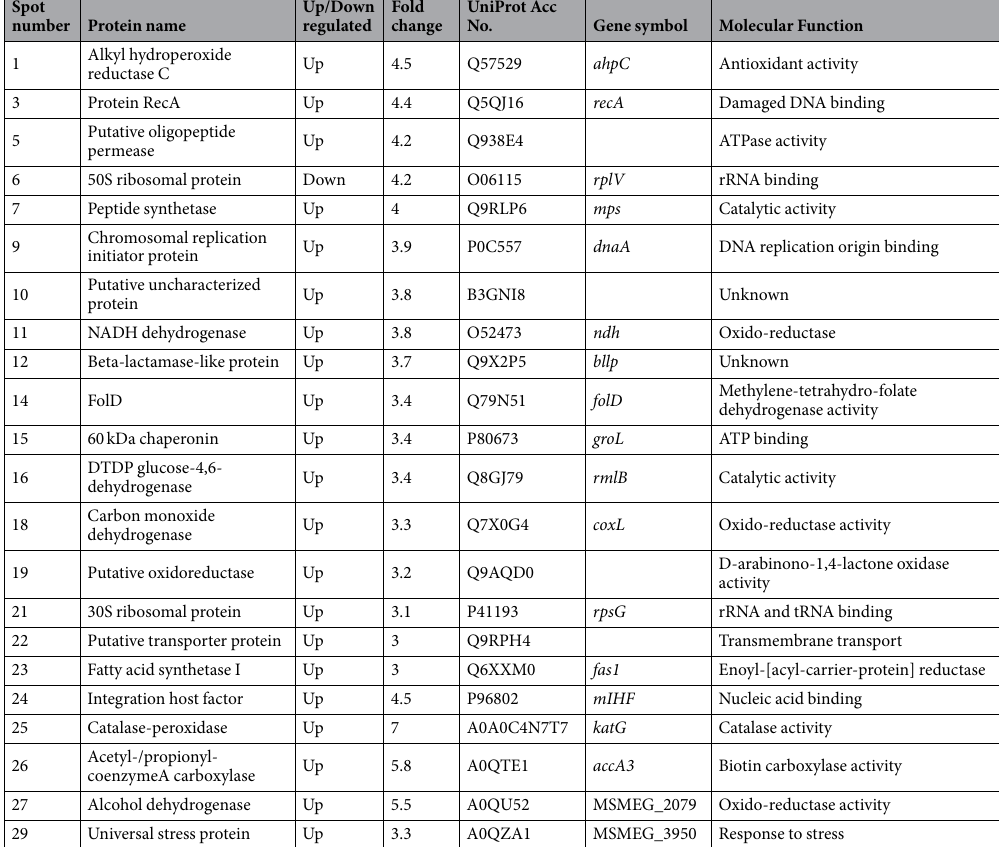
Table 1. Functional identification of the significantly differentially expressed proteins identified by nLC-MS/ MS between WT and MDP-1 KO M. smegmatis